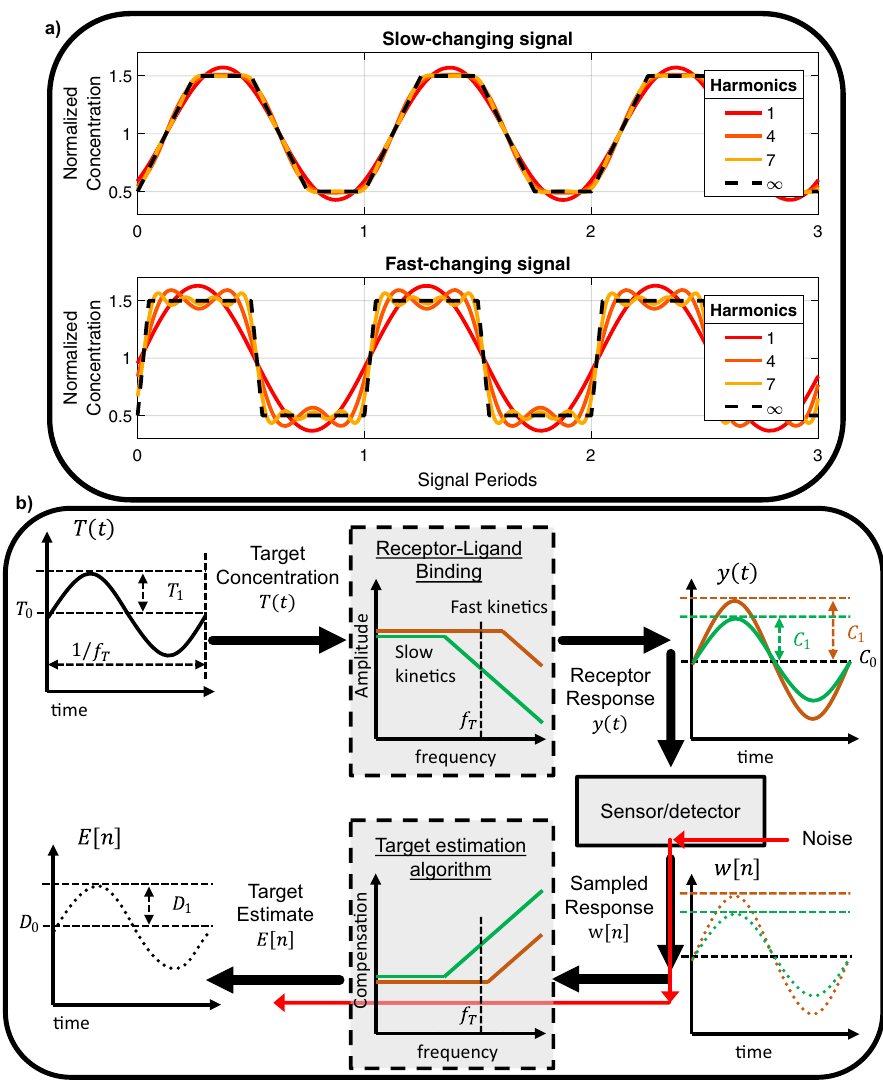
Fig.4|Frequency-domainanalysisofapre-equilibriumsensingsystem.a Slow- and fast-changing target concentration signals resolved with increasingly high- frequency content. High-frequency content is associated with fast-changing fea- tures in the waveform. A larger number of harmonics are required to resolve the sharp transitions of the fast-changing signal. b Weuseda sinusoidaltest signal T ( t ) with meanconcentration T 0 and amplitude T 1 to analyze the receptor ’ s